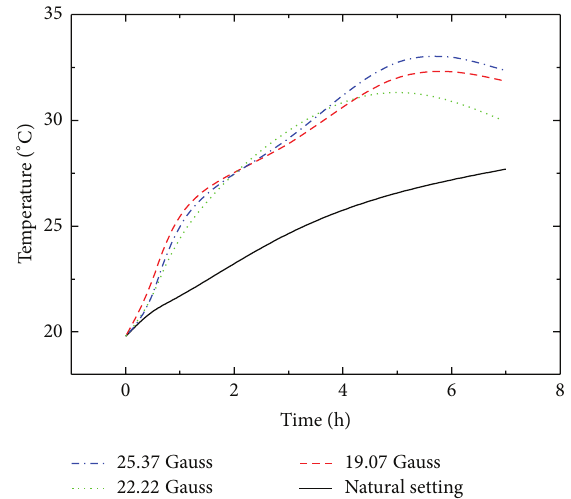
Figure 3: Surface temperature of fresh cement pastes during the exposure to magnetostatic